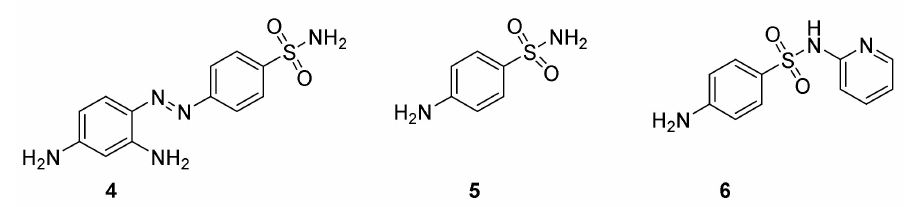
Figure 2. Prontosil ( 4 ), sulfonamide (4-aminobenzenesulfonamiode, 5 ) and 4-sulfapyridine ( 6